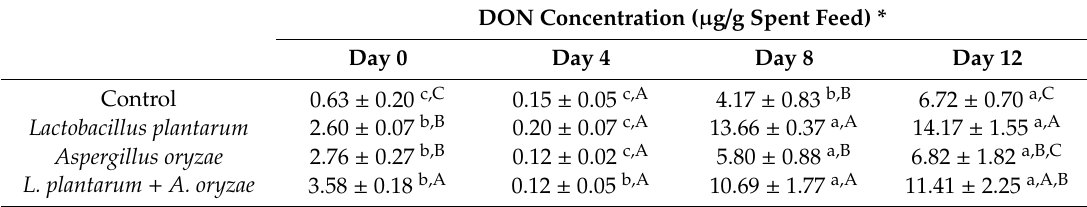
Table 1. Deoxynivalenol (DON) concentration in spent feed after black soldier fly larvae